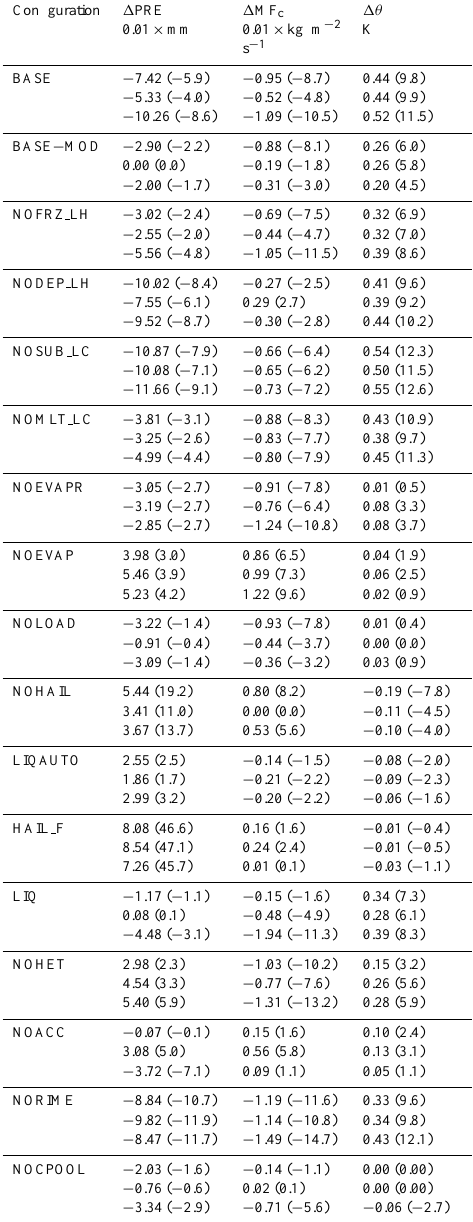
Table 2. Summary of results for the various model configurations. Presented results include the change in domain-mean accumulated surface precipitation ( 1 PRE), convective mass flux at a height of 8.25km ( 1 MF c ) , and lowest-level potential temperature averaged within the cold pool ( 1θ) between polluted and pristine conditions (POLL minus PRIS). For 1 MF c and 1θ , results are averaged be- tween t = 90 and 120min, while 1 PRE is the difference in accu- mulated precipitation at t = 120min. The top, middle, and lower values in each box are results from simulations with maximum θ 0 of the thermal to initiate convection of 3, 3.5, and 2.5K, respec- tively. The % change in each quantity relative to PRIS is given in